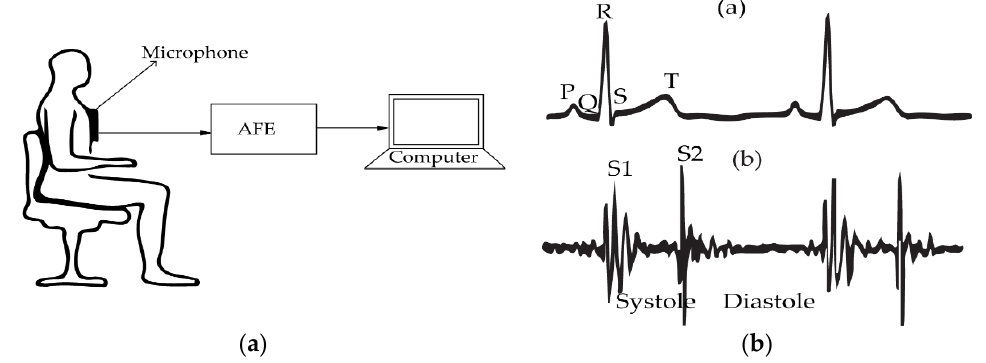
Figure 8. ( a ) Measurement setup of cardiac sound; ( b ) comparison of phonocardiography (PCG) and ECG signals.